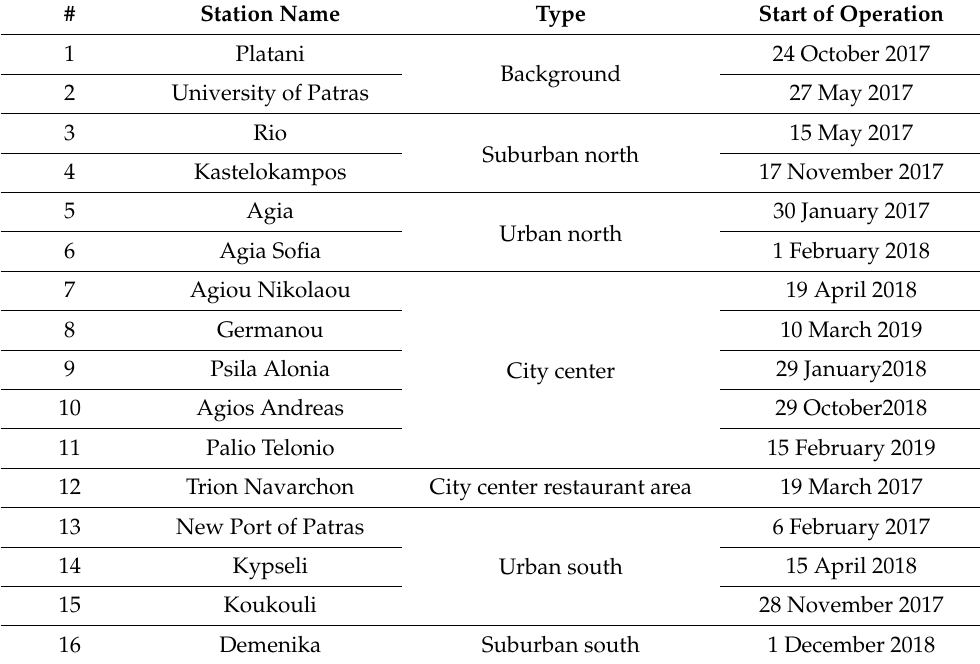
Table 1. Information about the stations of the low-cost PM 2.5 network in